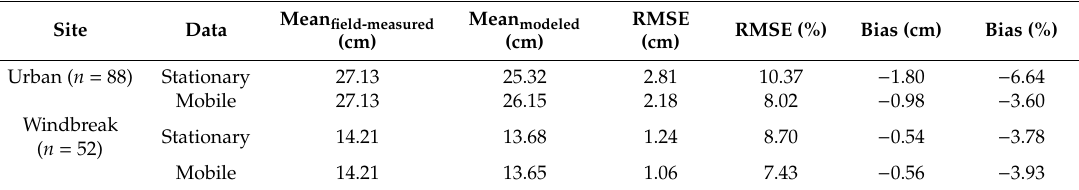
Table 2. A comparison between field-measured and modeled diameter at breast height for urban ( n = 88) and windbreak ( n = 52) trees. ( n = 88) and windbreak ( n = 52)